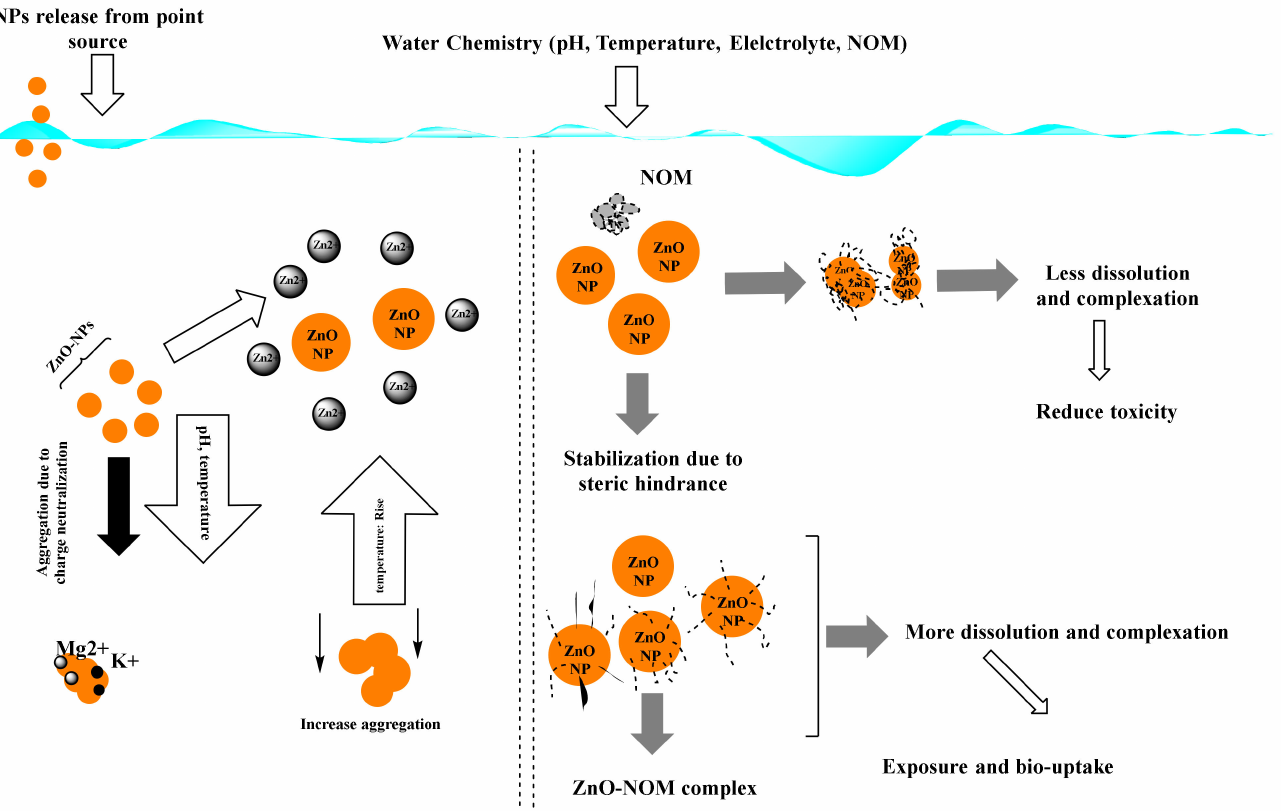
Figure 5. Releasing mechanism of ZnO-NP. Release of Zn 2+ ions (in the exposure medium, whether free or complexed with organic or inorganic